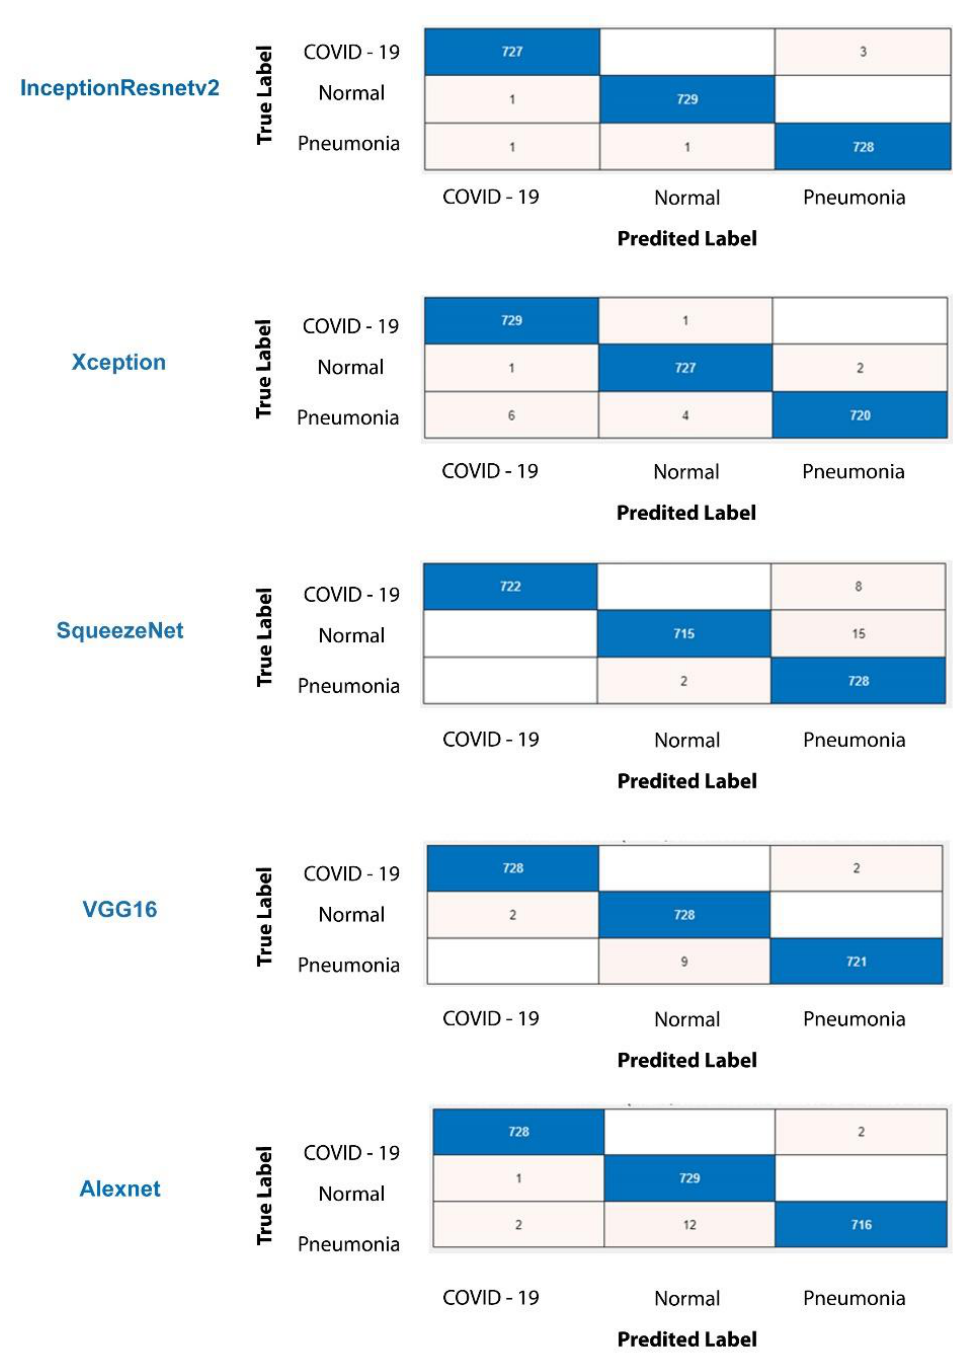
Figure 14. The confusion matrices of the deep transfer learning models.